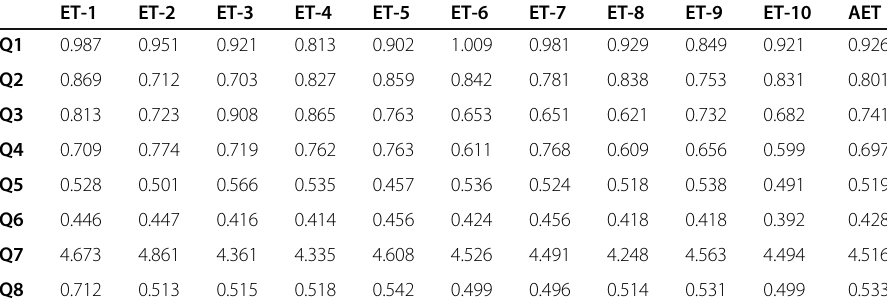
Table 18 Query execution time for local Kubernetes cluster with Colorado State for